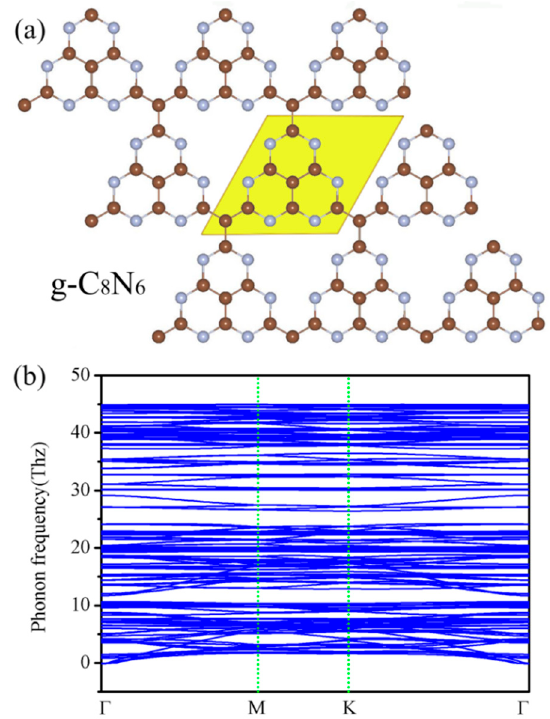
Figure 1. ( a ) Atomic structure of g–C 8 N 6 supercell (3 × 3 × 1), the primitive cell is marked using the yellow shaded area, brown atoms are C and gray atoms are N; ( b ) phonon spectral dispersion diagram of g–C 8 N 6 supercell (2 × 2 × 1).